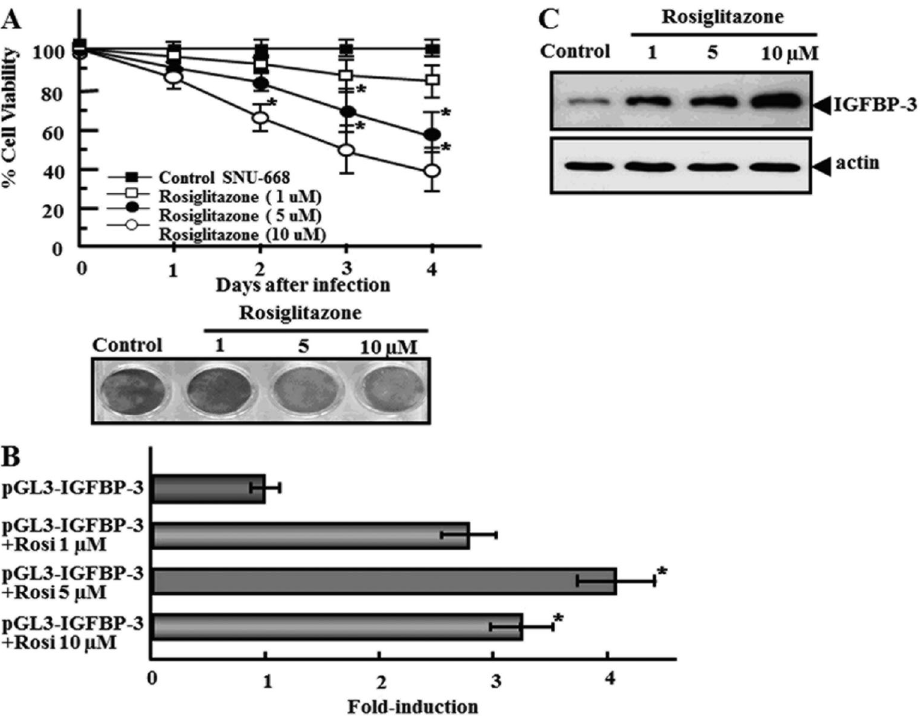
Figure 4. Effect of the peroxisome proliferator activator receptor-gamma (PPAR c ) agonist rosiglitazone (Rosi) on cell viability, IGFBP-3 promoter activity, IGFBP-3 expression. A , The effect of rosiglitazone on the viability of PPAR c transfected SNU-668 cells. Upper panel , PPAR c transfected cells were treated with various concentrations (1-10 m M) rosiglitazone and then allowed to grow under standard culture conditions for a further 4 days. The number of viable cells was determined by direct counting after trypan blue staining, and data are reported as the percent of the cell number before treatment. Lower panel , An equal number of cells were treated with increasing concentrations (1-10 m M) of rosiglitazone and incubated for 72 h. Cell viability was assessed using the crystal violet assay. B , Analysis of IGFBP-3 promoter activation by rosiglitazone. SNU-668 cells were transiently transfected with a luciferase reporter plasmid containing the full length IGFBP-3 promoter (pGL3-IGFBP-3), then infected with adenovirus-expressing (Ad)/PPAR c for 4 h. Twenty- four hours post transfection, luciferase activity was measured following treatment for an additional 24 h with rosiglitazone. C , Western blot analysis of GFBP-3 protein after rosiglitazone treatment in PPAR c transfected SNU-668 cells. The anti-actin blot indicates equal protein loading in each lane. Data are reported as means±SD of 3 independent experiments. *P , 0.05 compared to the absence of rosiglitazone treatment (Student’s t